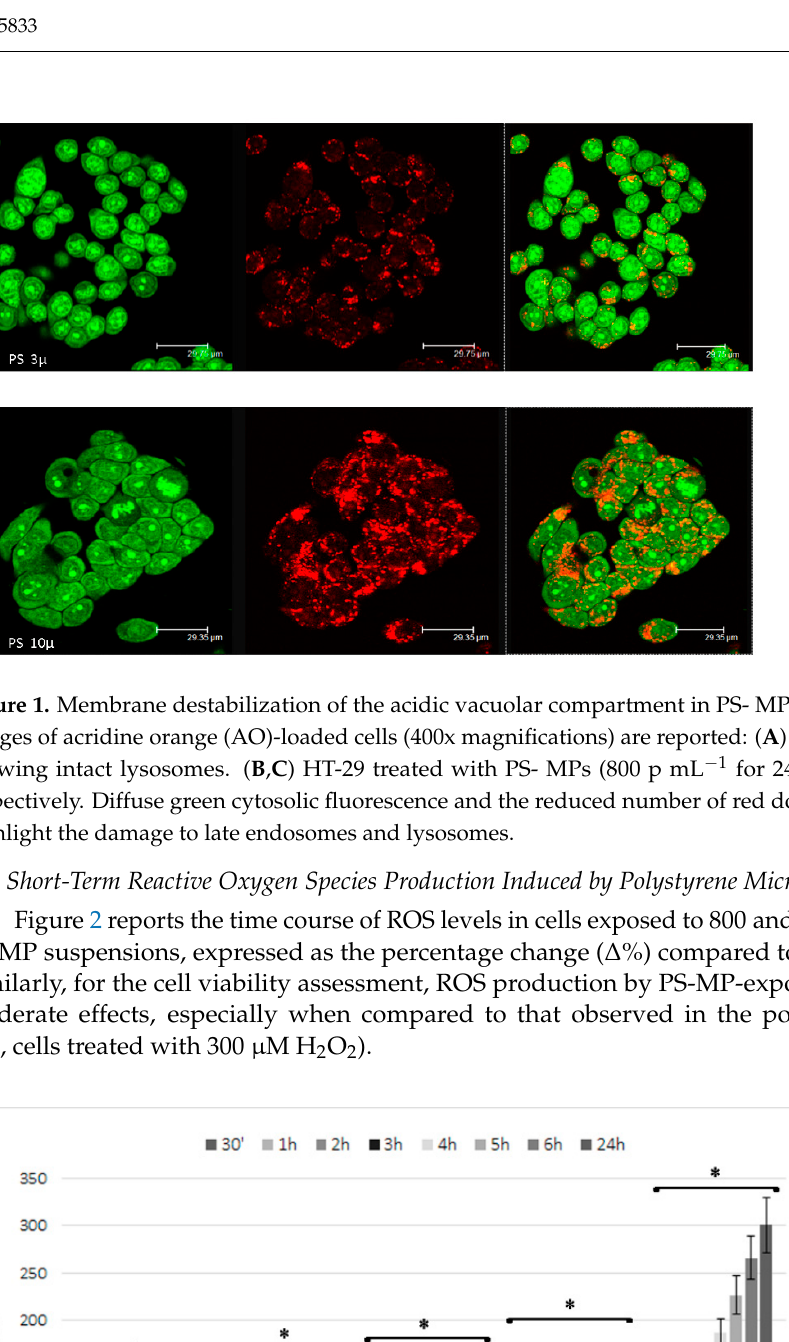
Figure 2. Time course of reactive oxygen species (ROS) production in PS- MPs exposed cells and in the positive control (H 2 O 2 treated cell). The values are expressed as Δ % in comparison to untreated cells. * Similarly to the positive control, a significant correlation between exposure time and ROS production was observed (* p < 0.05) for both MPs and at the two doses